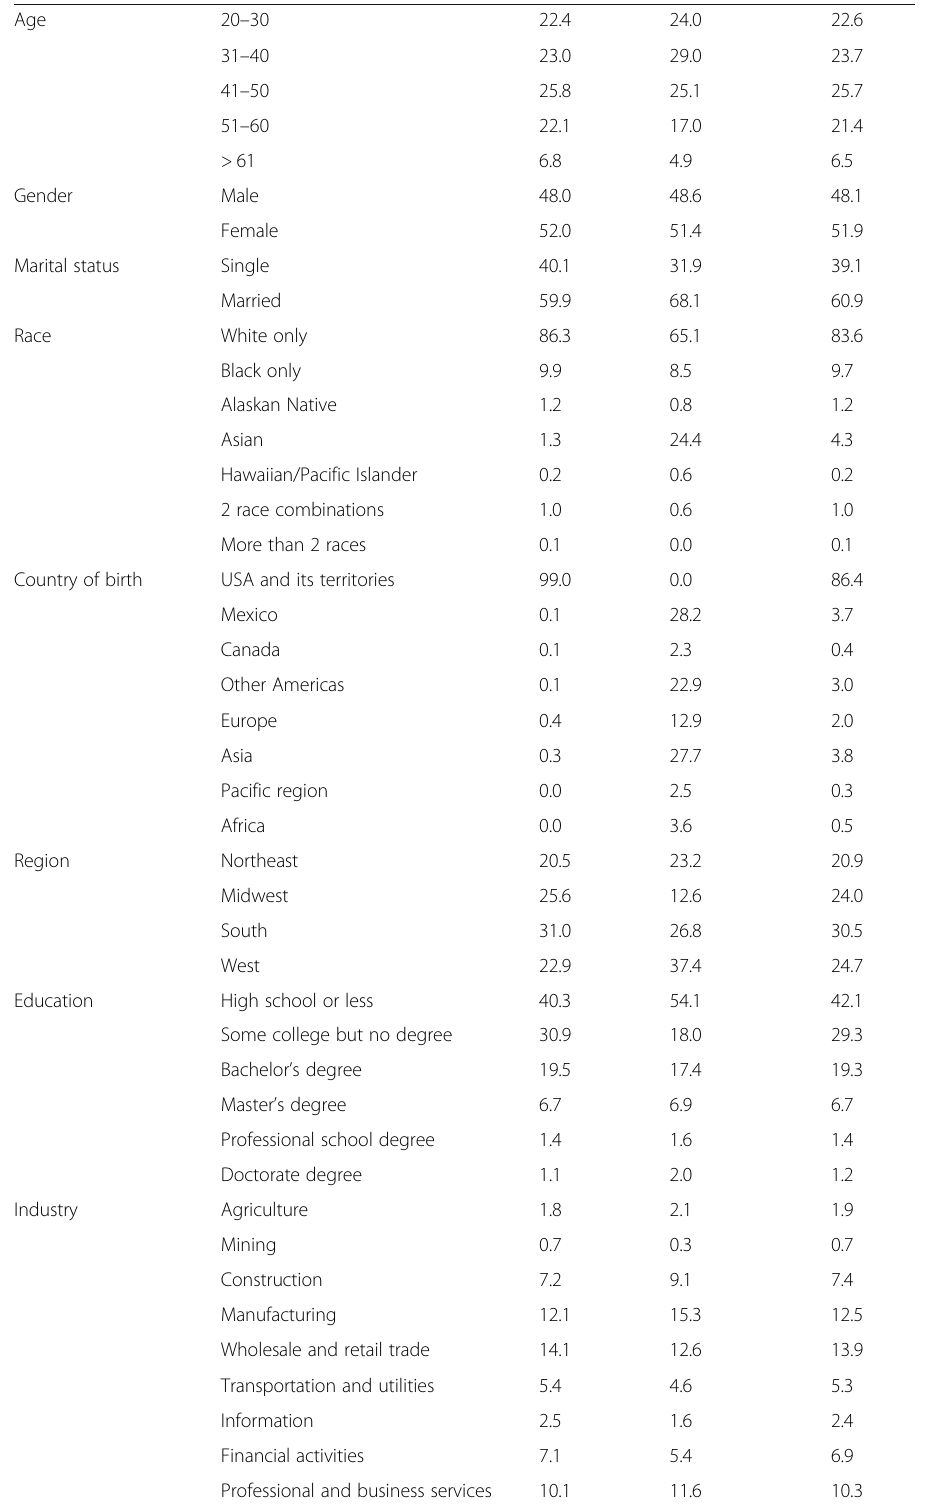
Table 1 Sample composition by immigrant status, CPS data, 1996 –